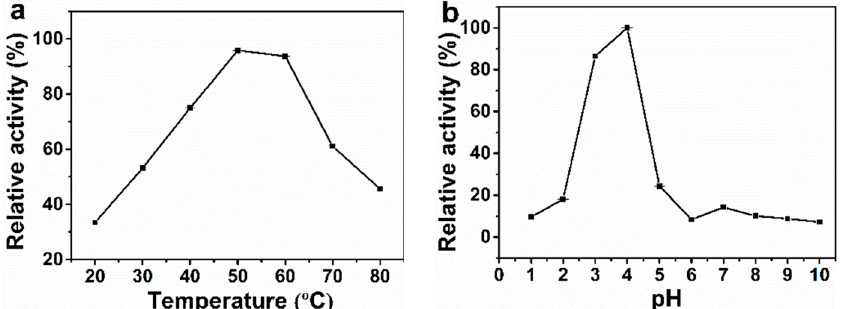
Figure 7. Effects of ( a ) temperature and ( b ) pH on the peroxidase-like property of Pt 600 -GLP NCs.